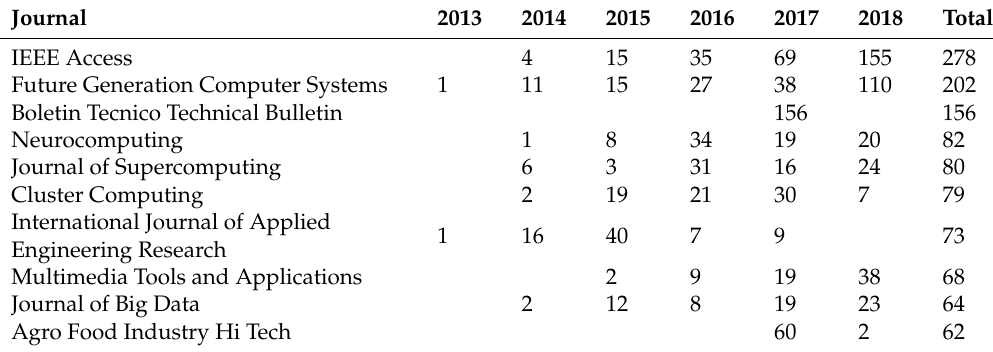
Figure 4. Top 10 journals in which the most numbers of documents regarding big data research were published. Table 1. Top 10 journals, the number of documents regarding big data research yearly and total published.